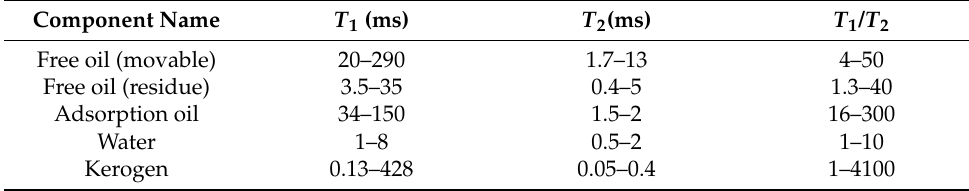
Table 1. The distribution range of various components of inter-salt